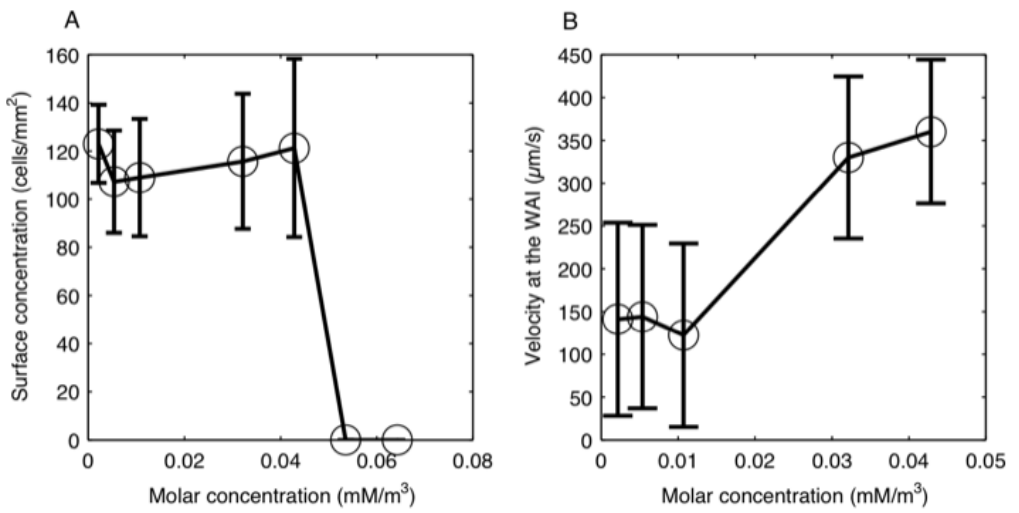
Figure 4. Effect of surfactant (Tween 20) concentration on the entrapment for day 5: (A) change in the surface concentration; note the presence of a step at 0.05 mM/m 3 , and (B) change in the swimming velocity at the WAI.